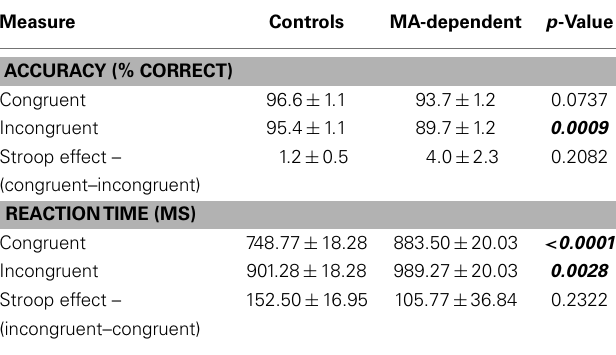
p-values are two-sided. Significant values are in bold